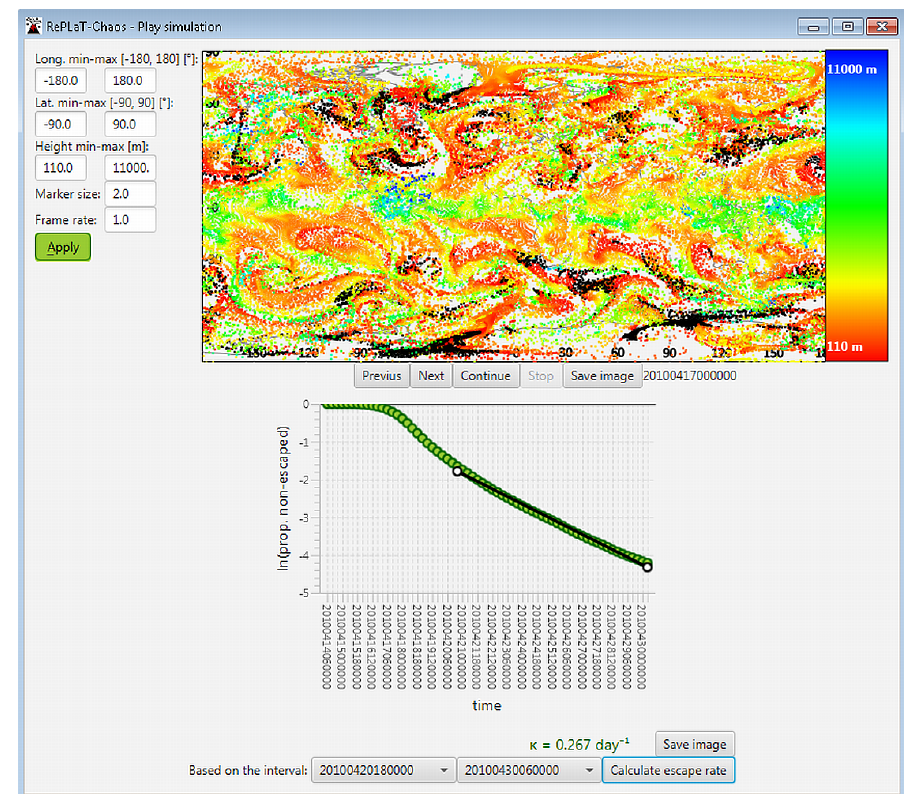
Figure A6. Displaying saved simulation and the time dependence of the ratio of non-escaped particles. The simulation is initialized with the simulation parameters on the left of Figure A1 but with an end date of “2010.04.30.06:00:00” and with calculating the ratio of non-escaped particles. The pollutant cloud is initialized as 250 × 250 × 1 particles at 0 ◦ N, 0 ◦ E and at the altitude of 5500 m with an extension of 4 × 10 4 km × 2 × 10 4 km × 0 m (i.e., covering the entire globe uniformly). The particle radius and density is 7 µ m and 2000 kgm − 3 ,